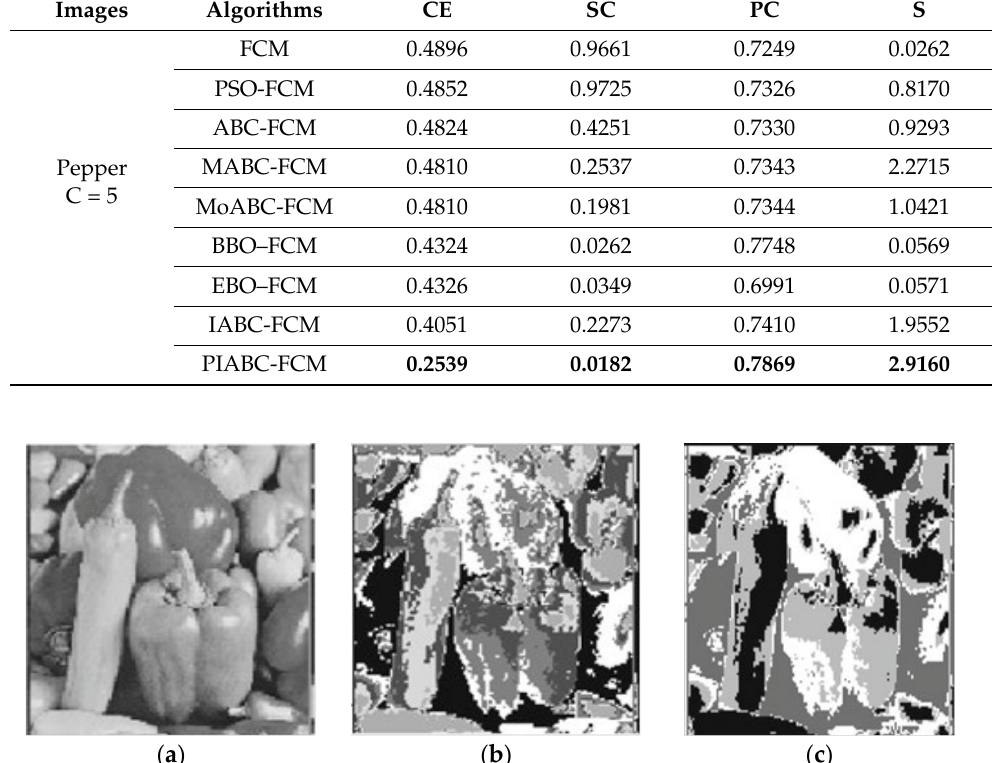
Figure 4. Pepper segmented image: ( a ) original image, ( b ) PIABC-FCM, and ( c ) IABC-FCM.